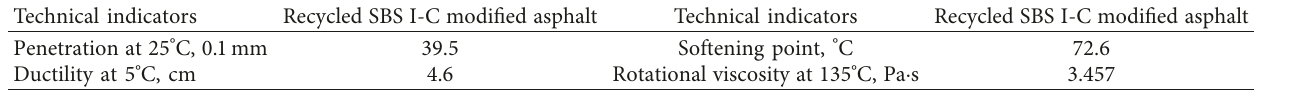
Table 3: Technical indicators of recycled SBS I-C modified asphalt.